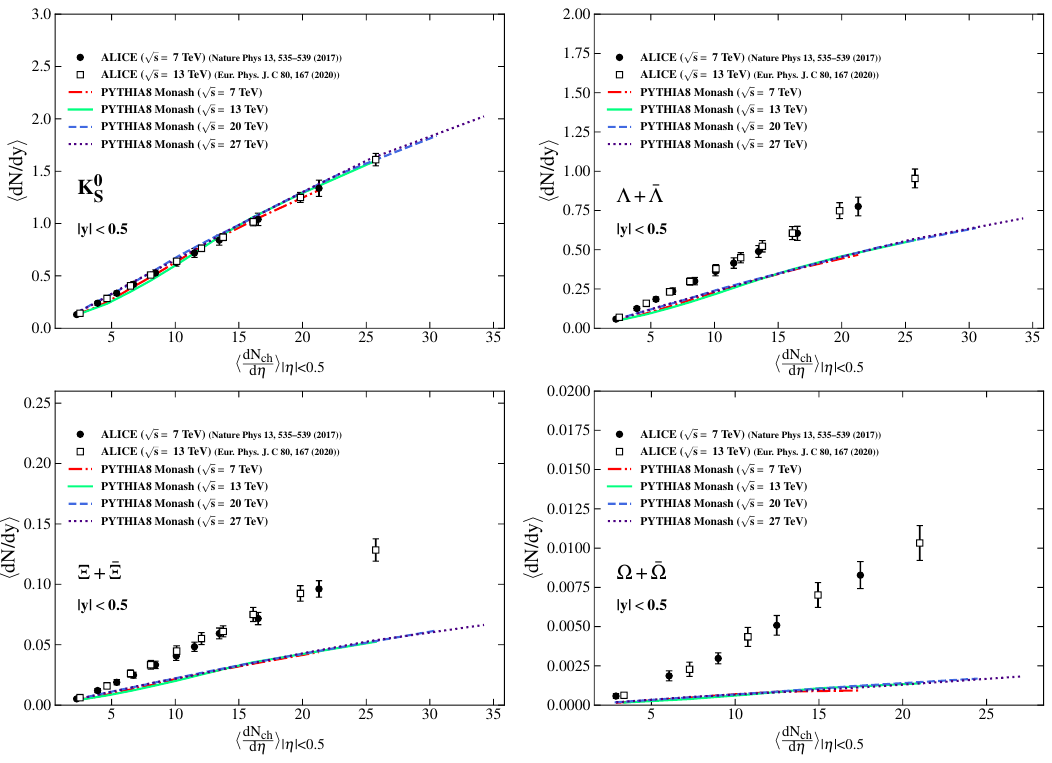
< 0.5 dN ch / d η y measured in (cid:104) (cid:105) | |